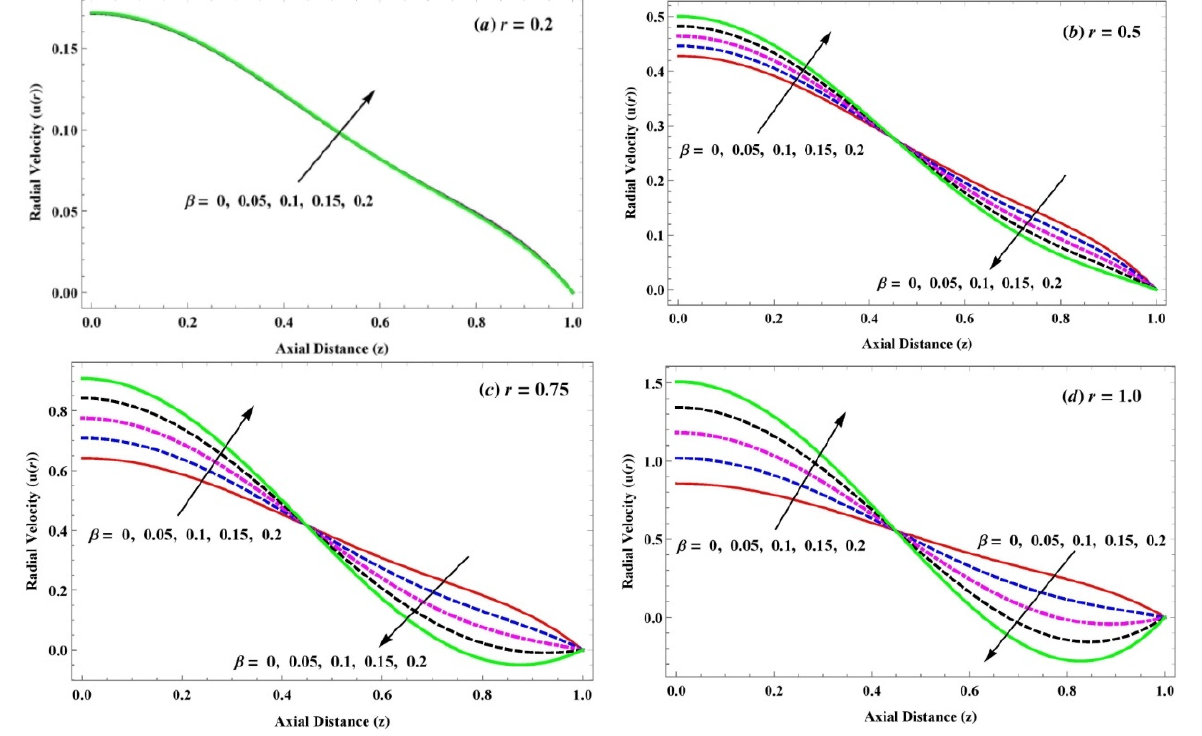
Figure 4. ( a – d ) Variation in radial velocity due to slightly viscoelastic parameter R e = 10, δ = 0.1 for ( a ) r = 0.2, ( b ) r = 0.5, ( c ) r = 0.75, ( d ) r = 1.0.